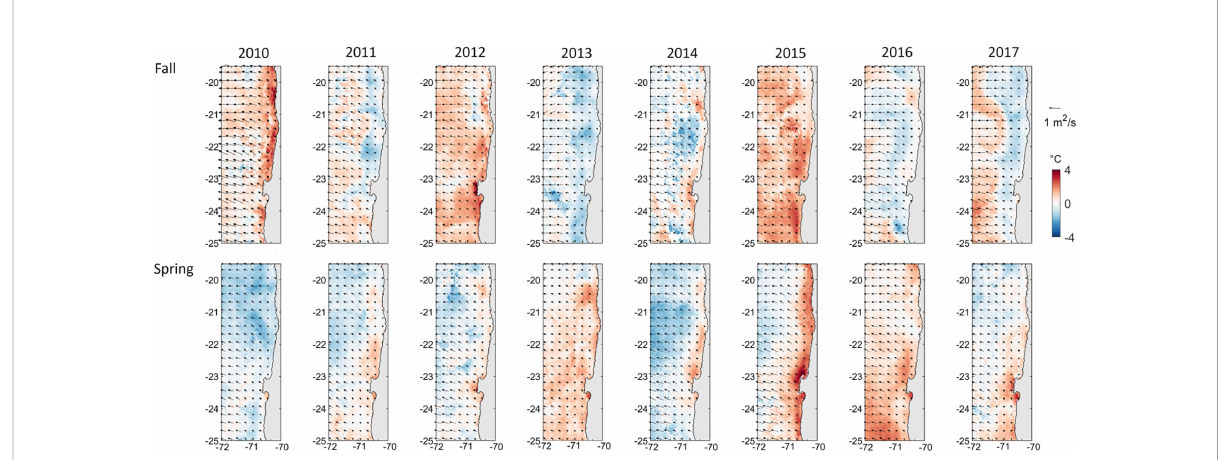
FIGURE 2 Monthly SST anomalies (°C) of every April (representative offall, upper panels) and December (representative of spring, lower panels). The vectors correspond to the mean Ekman transport vectors (m 2 s -1 ).